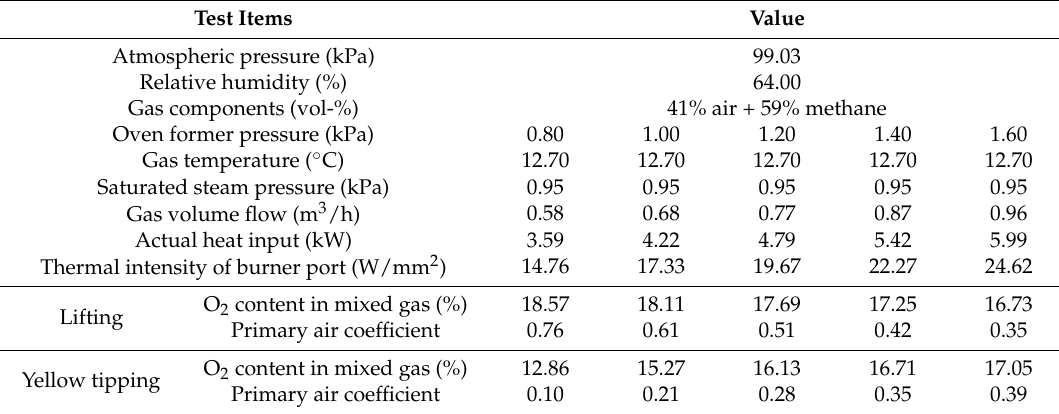
Table 7. Flame stability testing data of the comparative gas.